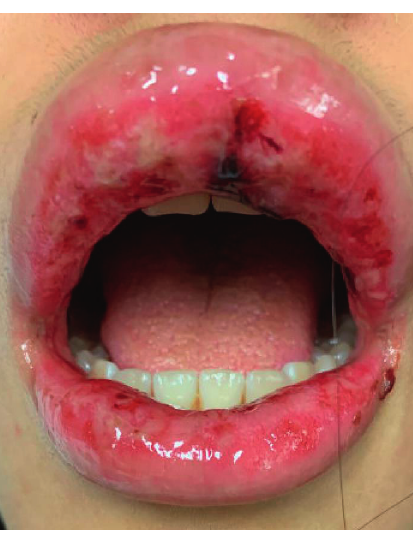
Figure 1: Ulcerated and edematous upper and lower lips at the time of presentation.